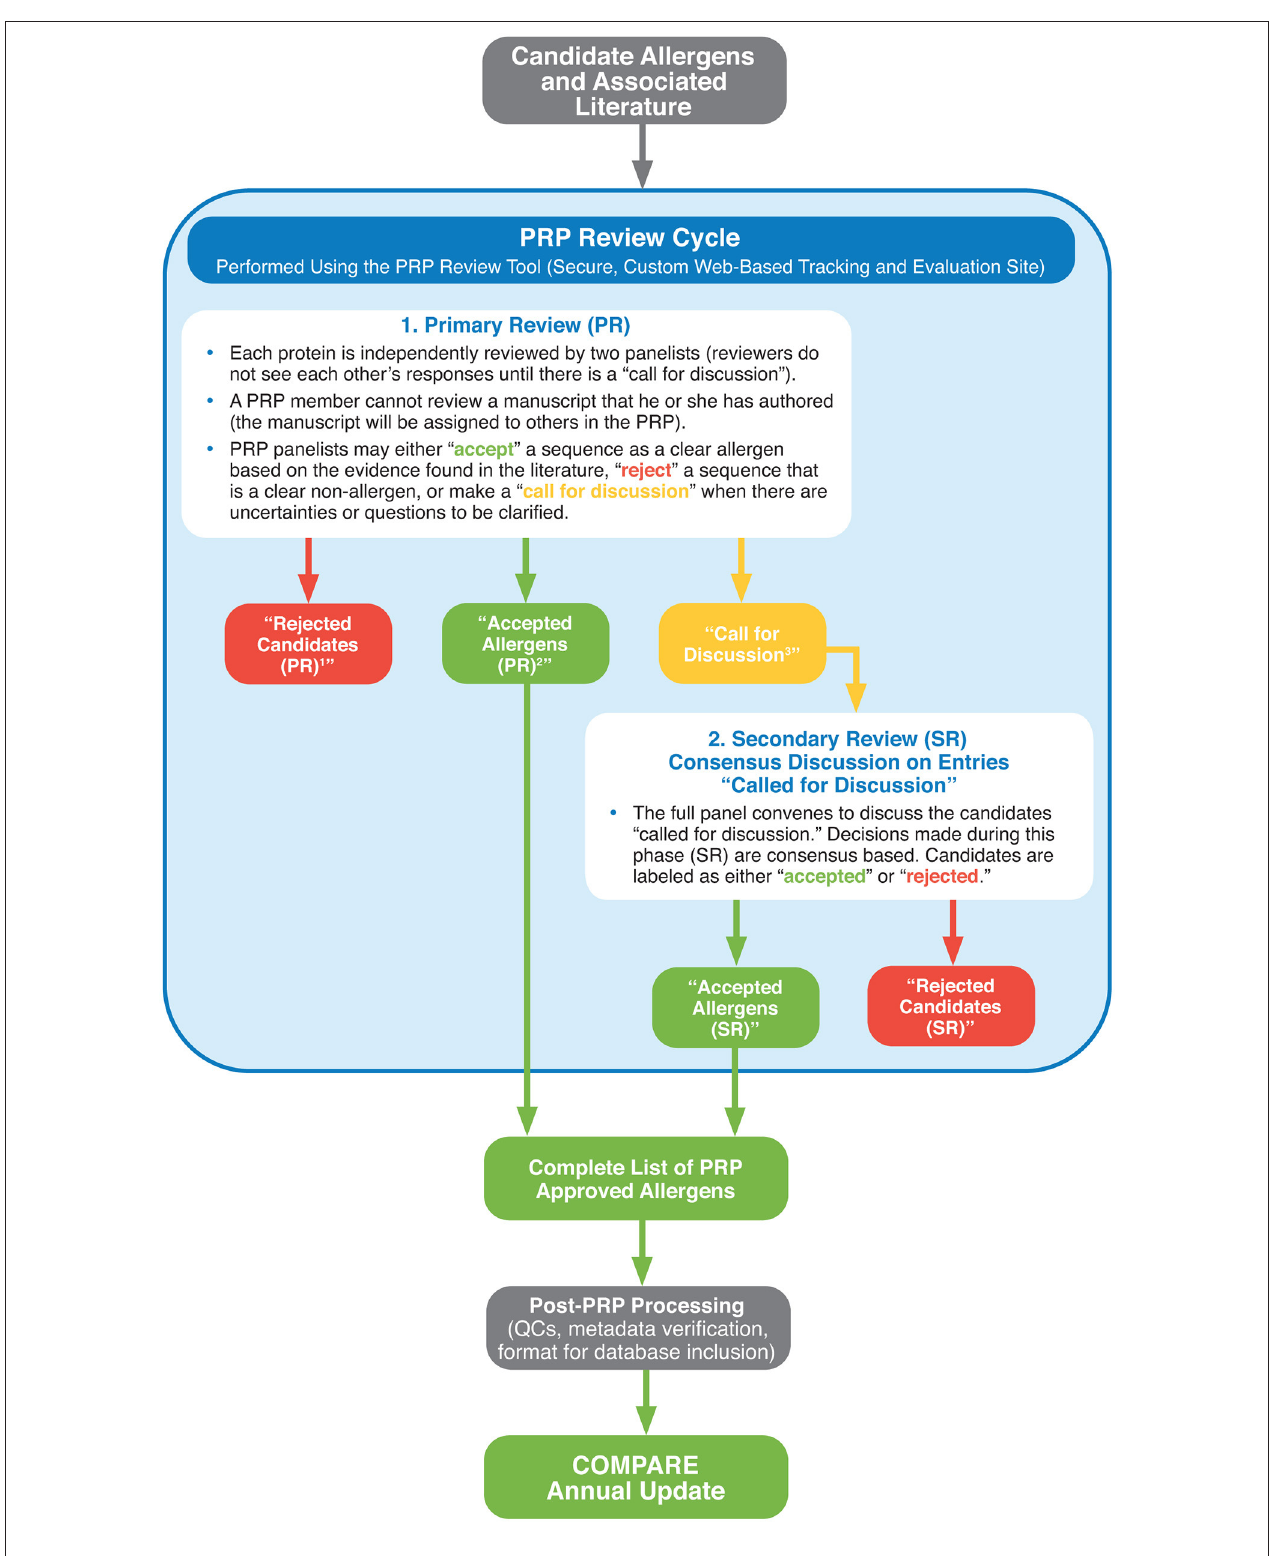
FIGURE 1 | Summary of the COMPARE Peer Review Cycle and Workflow for each annual update.